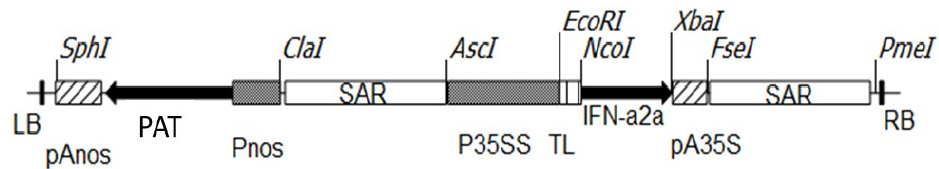
Figure 1. IFN- α 2a gene expression construct.pTRA-PT, a derivative of pPAM (gi13508478) with a constitutive CaMV p35SS promoter and the 5 ′ UTR of the Tobacco Leader peptide (TL) was used for IFN- α 2a expression in Raphanus sativus L. plants. RB/LB: right and left border sequences of nopaline-Ti-plasmid pTiT37. pAnos: polyadenylationsignal of nopaline synthetase gene derived from Agrobacterium tumefaciens . PAT: phosphinothricin acetyltransferase gene that confers resistance to BASTA (phosphinothricin). Pnos: nopaline synthase promoter of A. tumefaciens . IFN- α 2a expression cassette is flanked by the 3 ′ UTR of CaMV (pA35S) and the scaffold attachment region (SAR) of the tobacco RB7 gene (gi3522871).